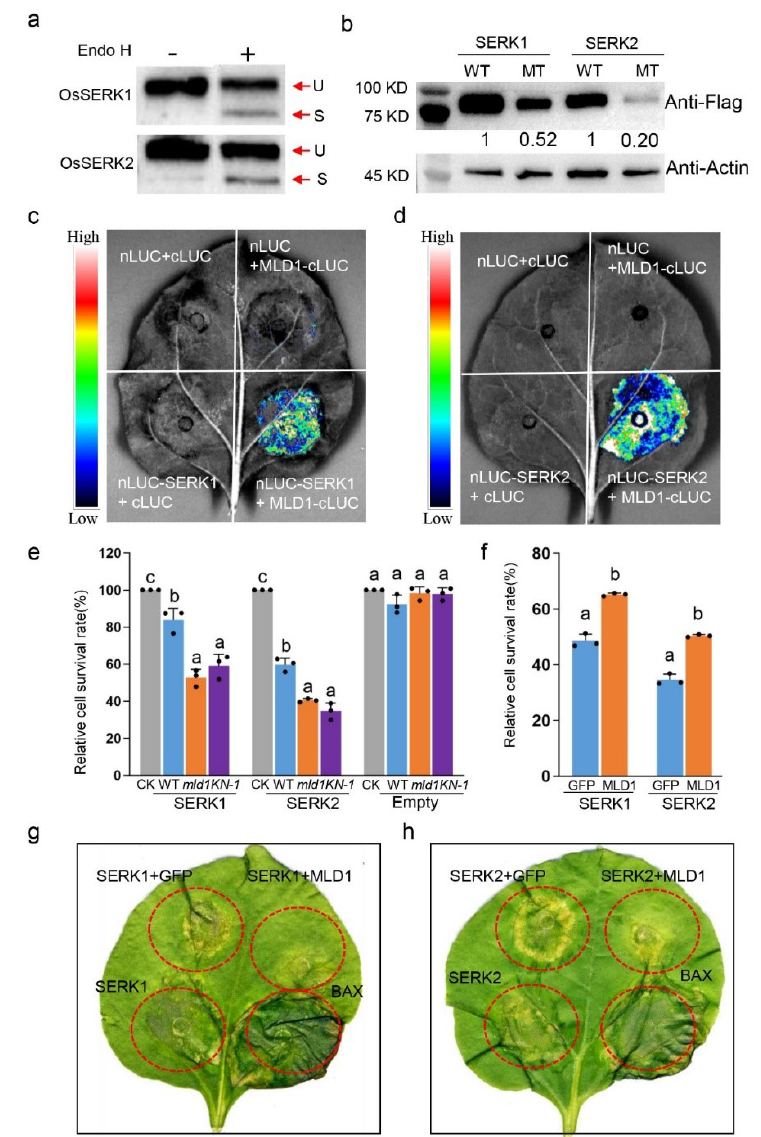
Figure 6. OsMLD1 interacts with OsSERK1 and OsSERK2 and suppresses their induced cell death. ( a ) Western blot analysis with anti-FLAG showed that glycans were cleaved from OsSERK1 or OsSERK2 by Endo H. Red arrow indicates uncleaved (U) or cleaved. ( b ) Western blot analysis OsSERK1 or OsSERK2 transiently expressed in protoplast of wildtype and mld1 mutant. ( c , d ) Firefly LUC complementation imaging (LCI) assay detecting the interactions of OsMLD1 with OsSERK1 and OsSERK2, respectively. ( e ) Survival rates of protoplasts measured in WT, mld1, and KN-1. OsSERK1, OsSERK2, the empty vector, and luciferase were co-expressed in the protoplasts of the WT, mld1 and KN-1 , respectively. The only pUBI:LUC plasmid DNA was used to normalize the protoplasts in each treatment, representing 100% viable cells. In contrast, survival rates after OsSERK1 and OsSERK2 transformation were obtained. The empty vector was used as a negative control in each treatment. Data are the means ± SD ( n = 3). Significance analysis was performed using two-factor ANOVA with Tukey’s HSD test. Different letters indicate significant differences ( p < 0.05). ( f ) Survival rate of co-expressed OsSERK1 or OsSERK2 with OsMLD1-GFP or GFP in mld1 protoplasts. ( g , h ) OsMLD1 suppresses OsSERK1- or OsSERK2-induced cell death in N. benthamiana . OsSERK1 and OsSERK2 alone or with OsMLD1 were transformed into N. benthamiana epidemical cells. The co-expression of OsSERK1 with GFP and OsSERK2 with GFP was used as a negative control, and BAX was used as the positive control.